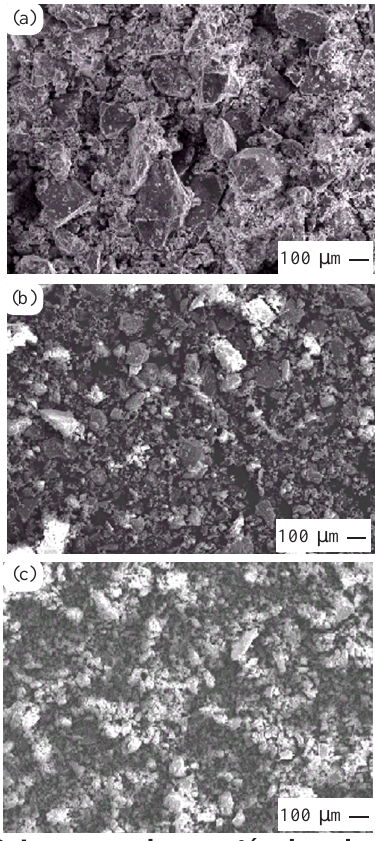
Figura 3. Imagens das partículas do calcário dolomítico obtidas por microscópio eletrônico de varredura (MEV), antes da aplicação na superfície do solo (a), acumulado nos filtros após a primeira (b) e segunda adição de água